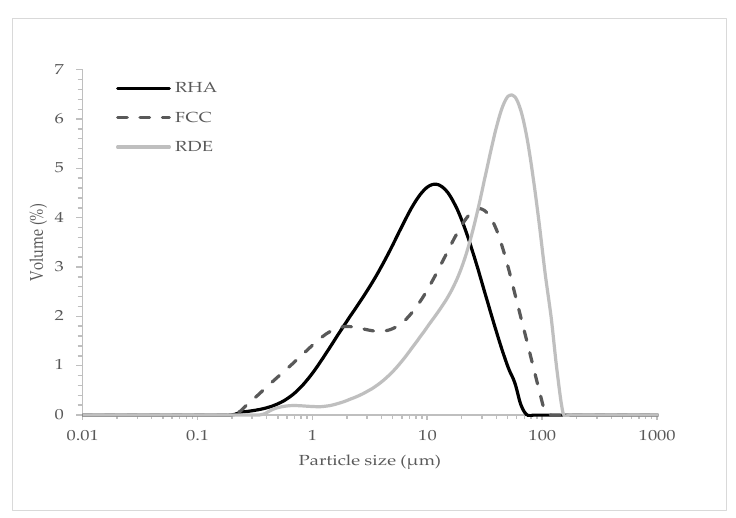
Figure 1. Particle size distribution curves of FCC, RHA and RDE.